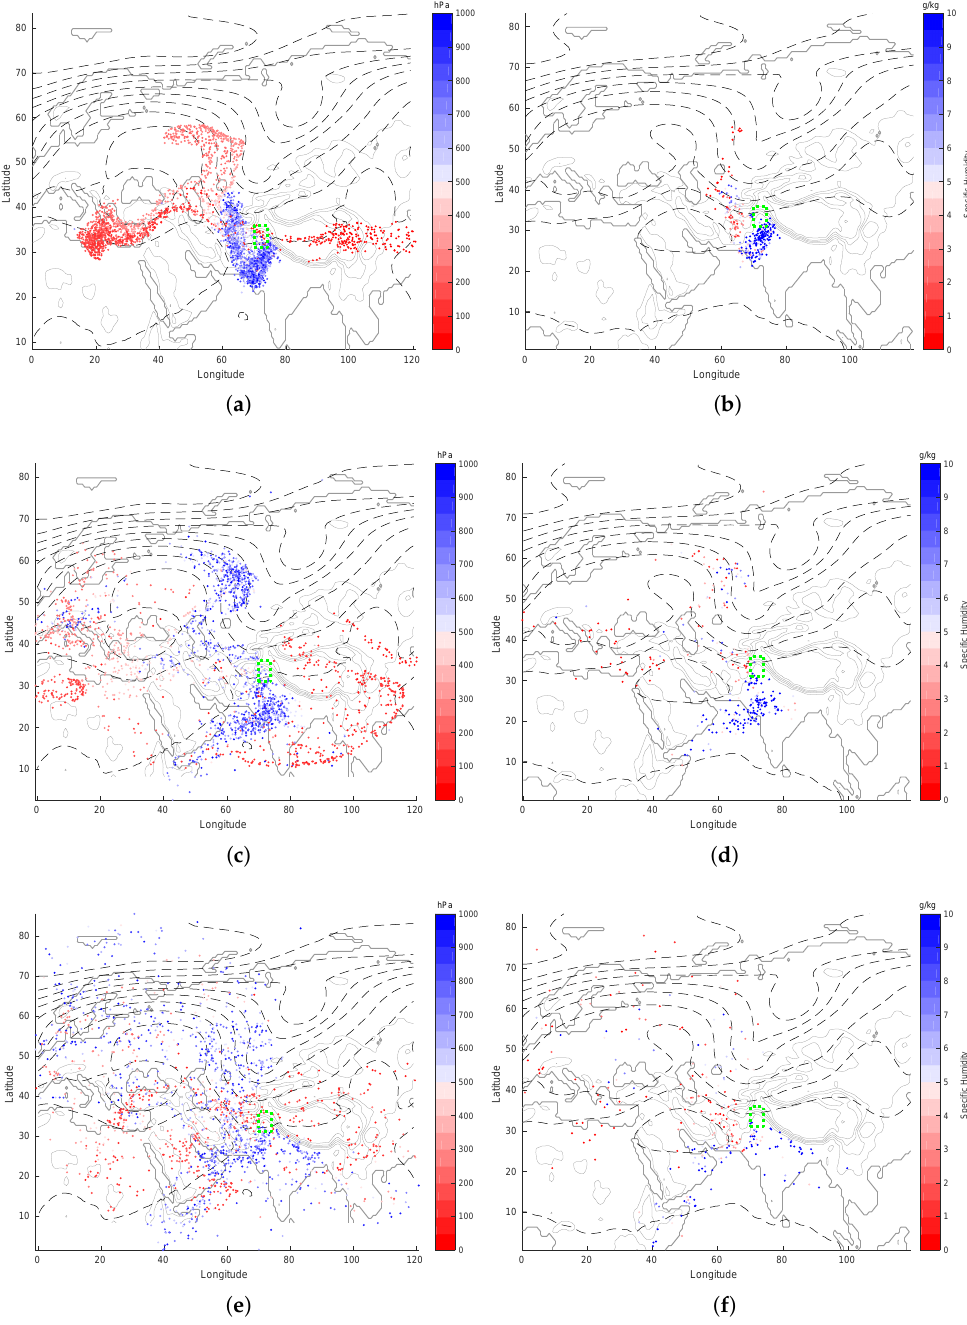
Figure 10. All back-trajectories emanating from NP on 22 July 2010. ( a ) parcel pressure, 2 days back in time, along the parcel trajectory; ( b ) parcel pressure, 2 days back in time, along the parcel trajectory; ( c ) parcel pressure, 6 days back in time, along the parcel trajectory; ( d ) specific humidity, 6 days back in time, along the parcel trajectory; ( e ) specific humidity, 10 days back in time, along the parcel trajectory; ( f ) specific humidity, 10 days back in time, along the parcel trajectory. The dashed lines indicate the 5 and 2 day means of 500 mb geopotential height for the left and right columns,